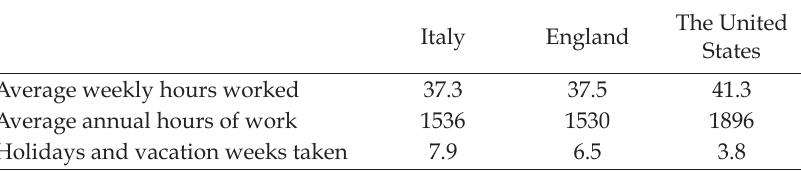
Table 4. Work and leisure – all